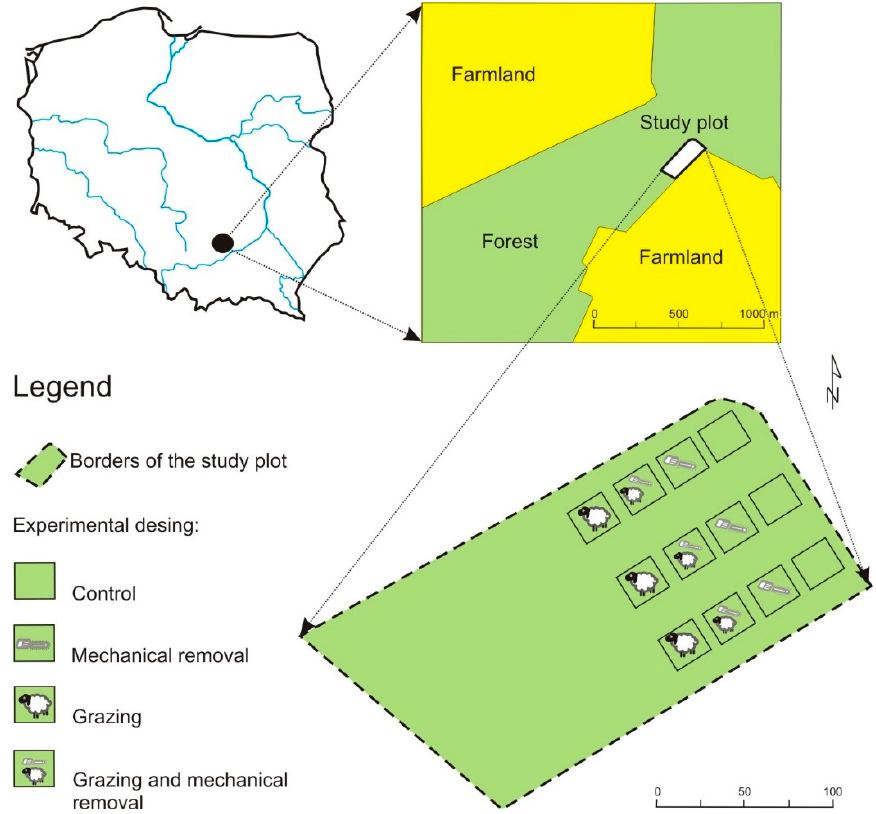
Figure 1. Study site location and study plot design. The area delimited as the study plot is part of the bigger (7.70 ha) fenced forest treated by sheep grazing.